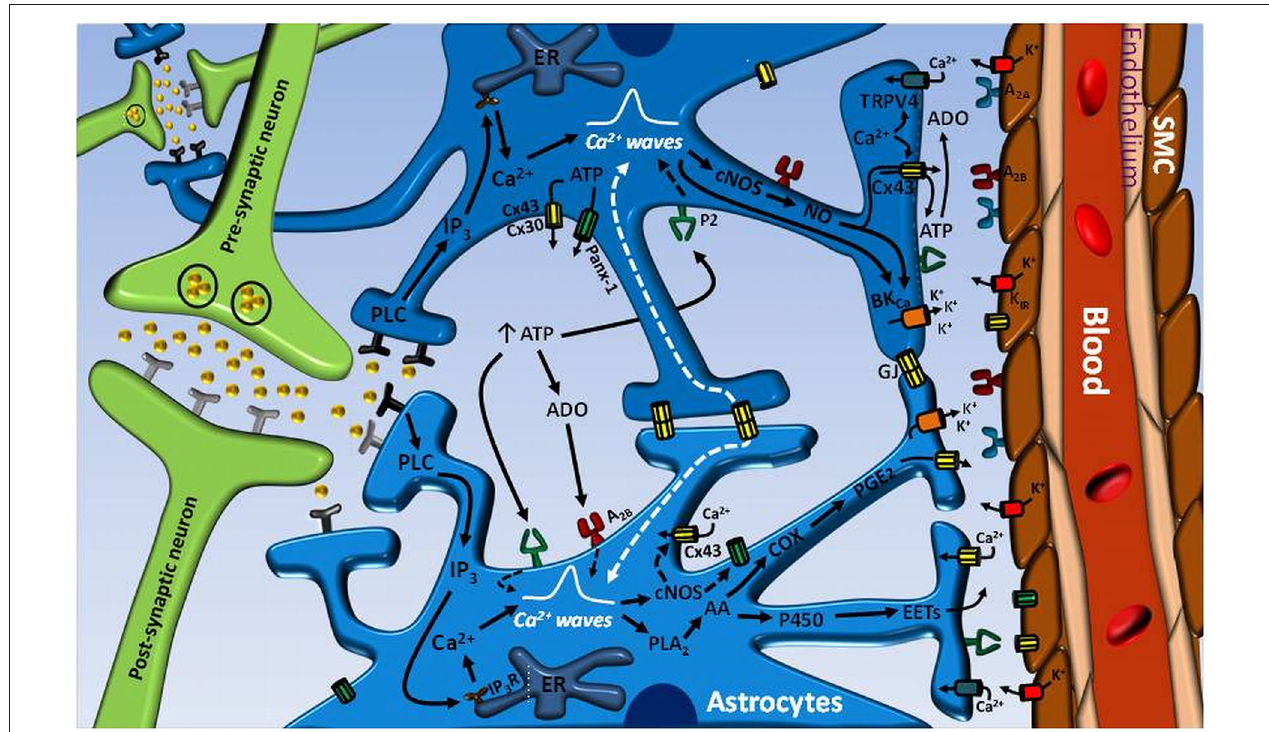
FIGURE 1 | Astrocyte-mediated signaling mechanisms involved in the control of neurovascular coupling . Neurotransmitters released during an increase in neuronal activity can exit the synaptic cleft and activate receptors on astrocyte processes. The stimulation of astrocyte receptors initiates an inositol 1, 4, 5-triphosphate (IP 3 ) receptor (IP 3 R)-mediated Ca 2 + signal that is propagated through the astrocytic processes into the endfeet and